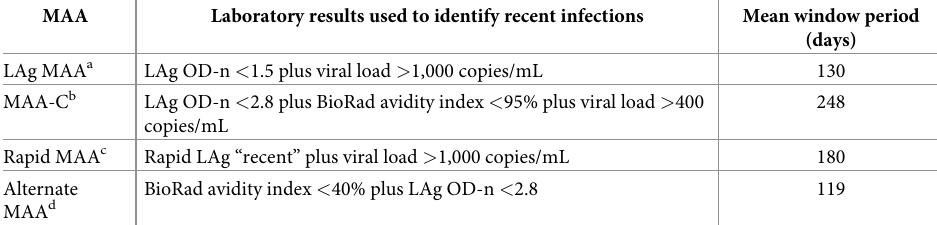
Table 1. Multi-assay algorithms evaluated in this report.